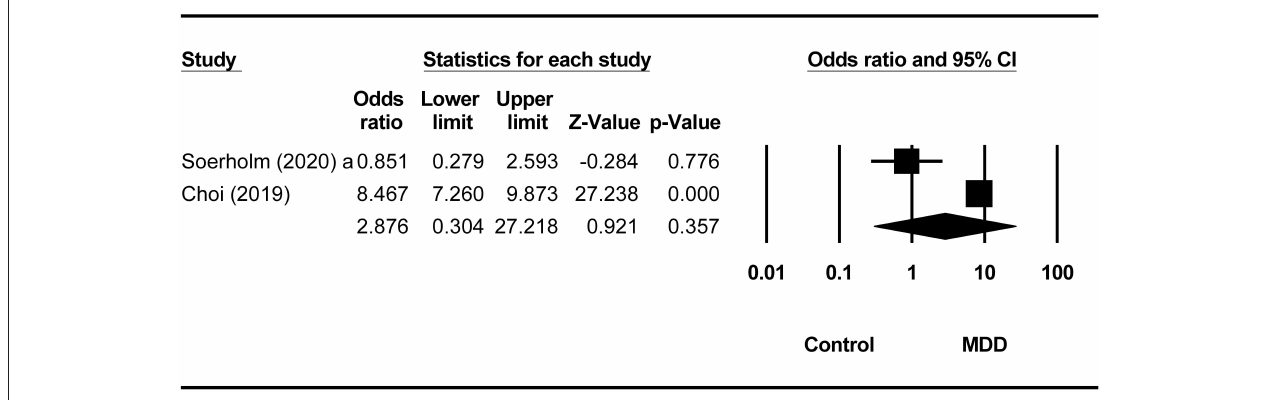
FIGURE 2 | Comparison of lifetime prevalence of suicide ideation between the MDD group and non-MDD groups.